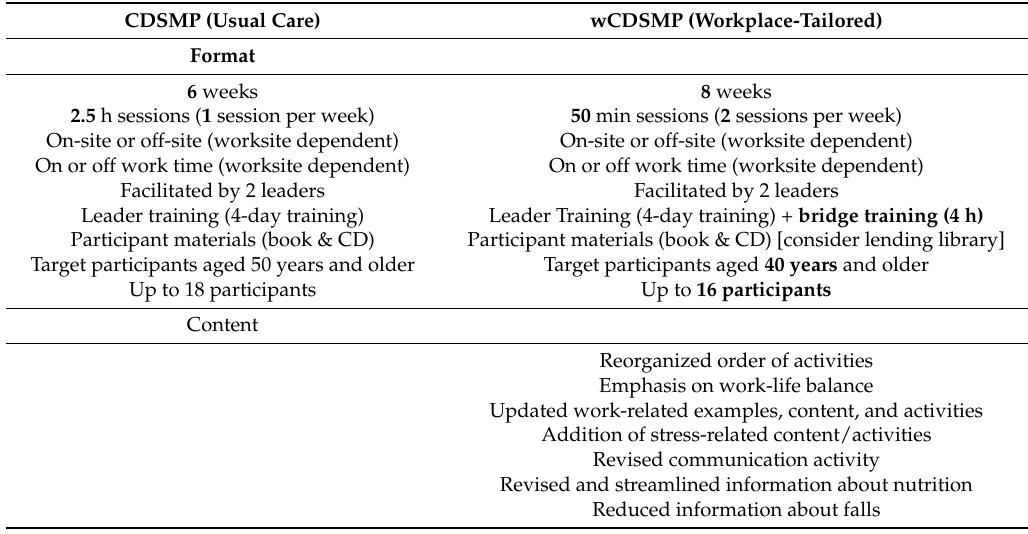
Table 1. Comparison of the Chronic Disease Self-Management Program (CDSMP) and the worksite-tailored version of CDSMP (wCDSMP) workshop